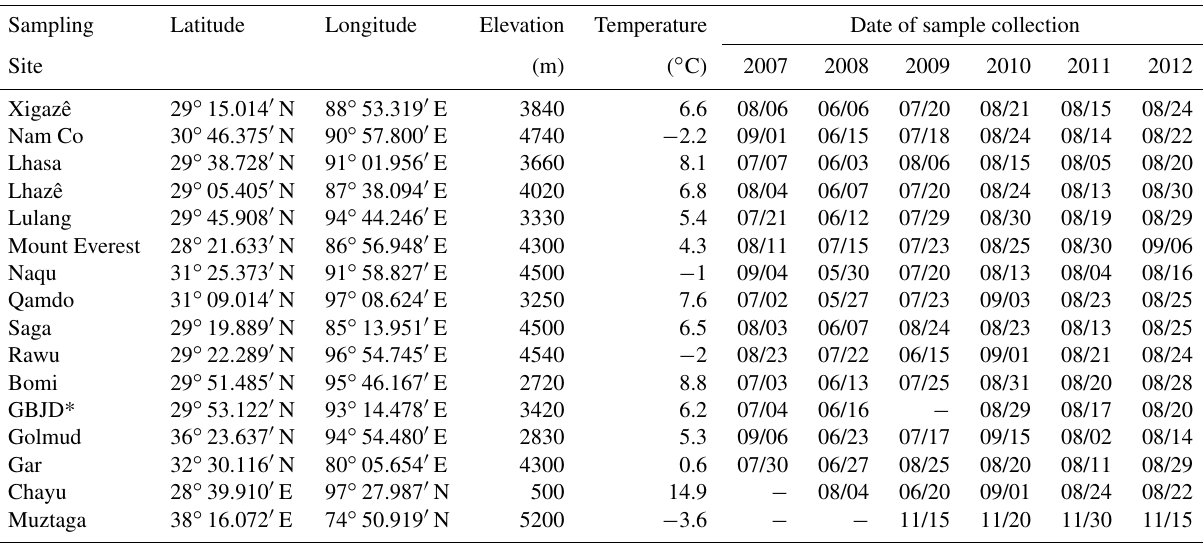
Table 1. Information of sampling sites and the date of sample collection for each year.